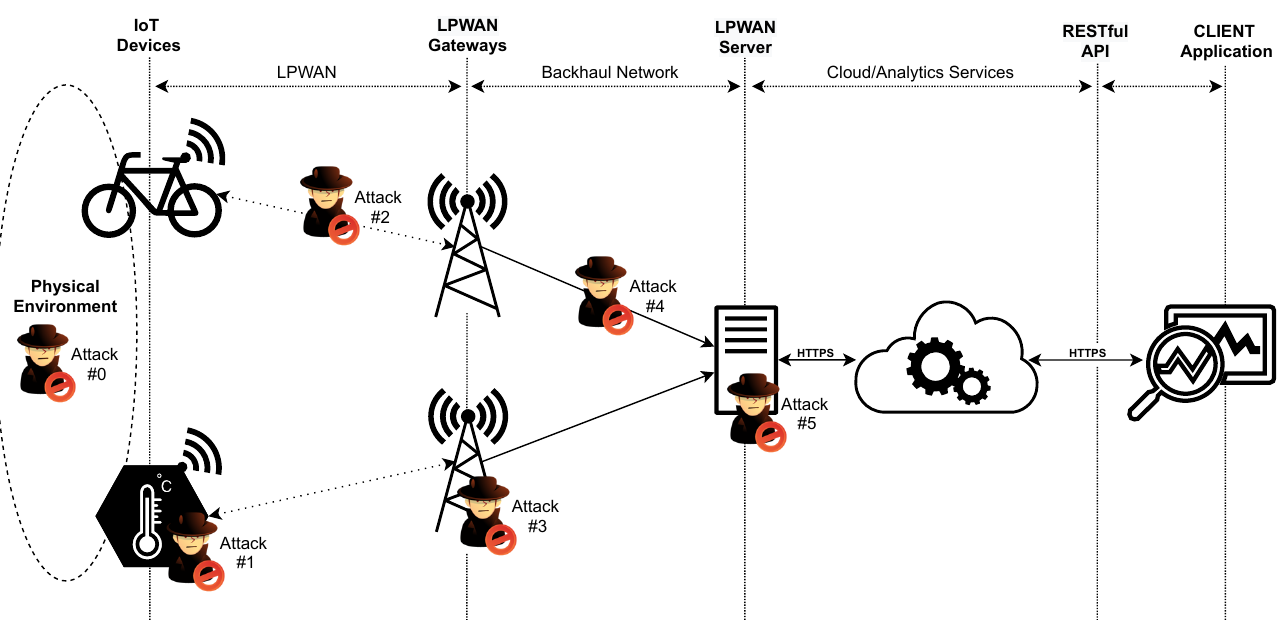
Figure 12. Definition of Attack Vectors in Low Power Wide Area Networks (LPWAN)-based Internet of Things (IoT)